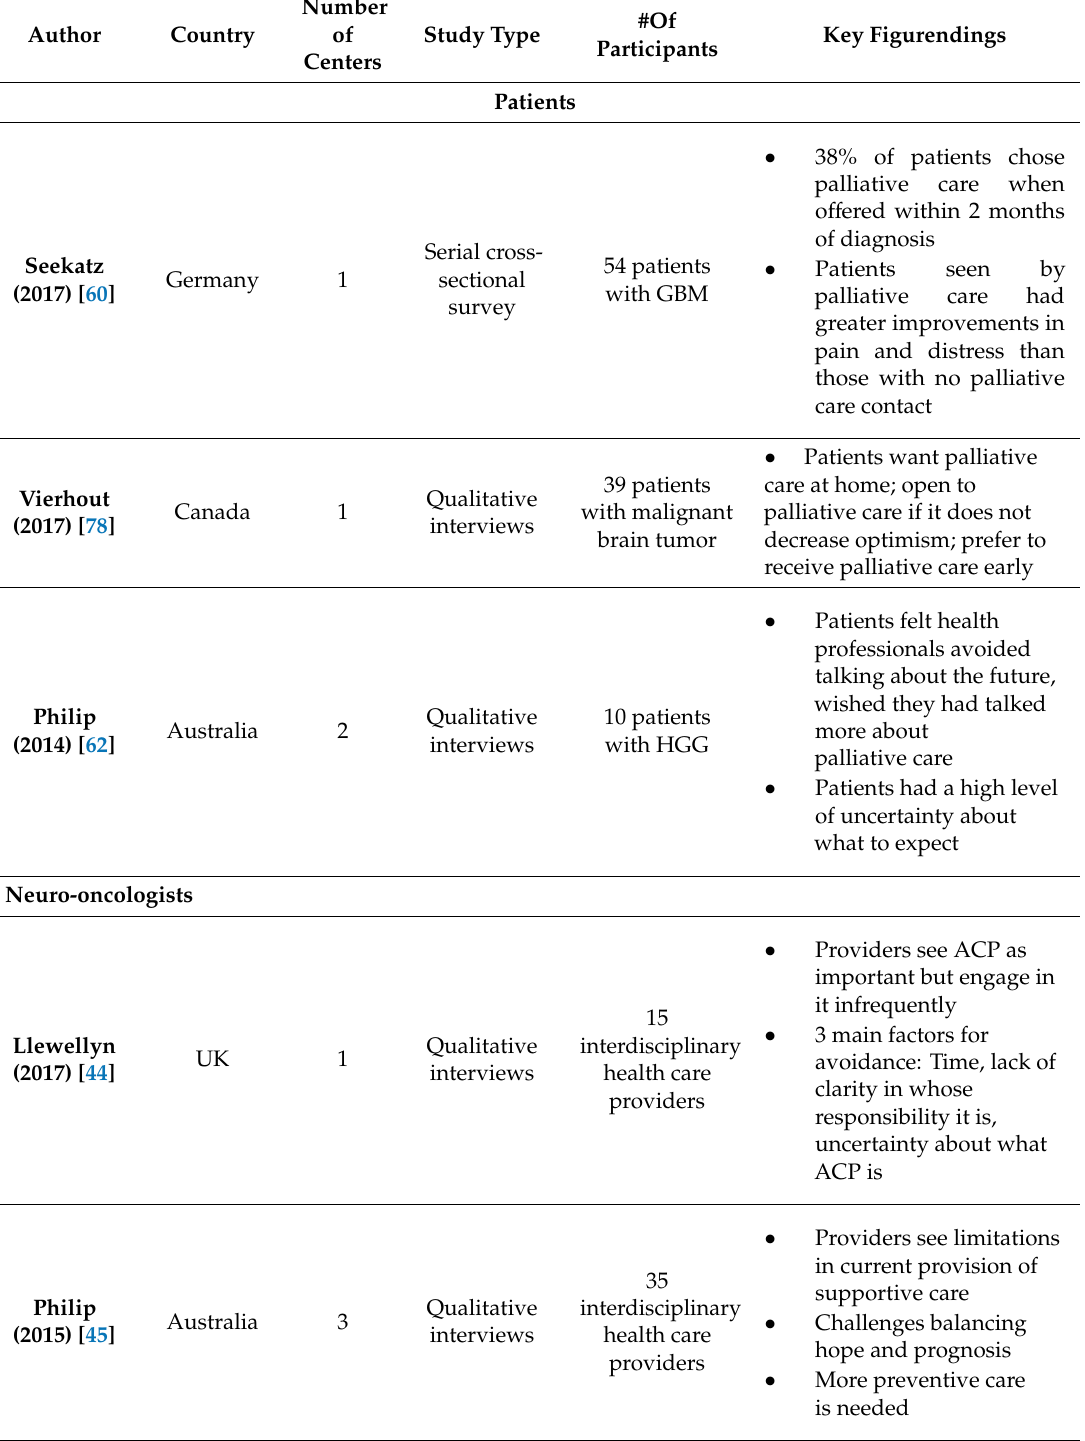
Table 5. Summary of the literature on the view and preferences of high-grade glioma patients and neuro-oncologists with respect to palliative